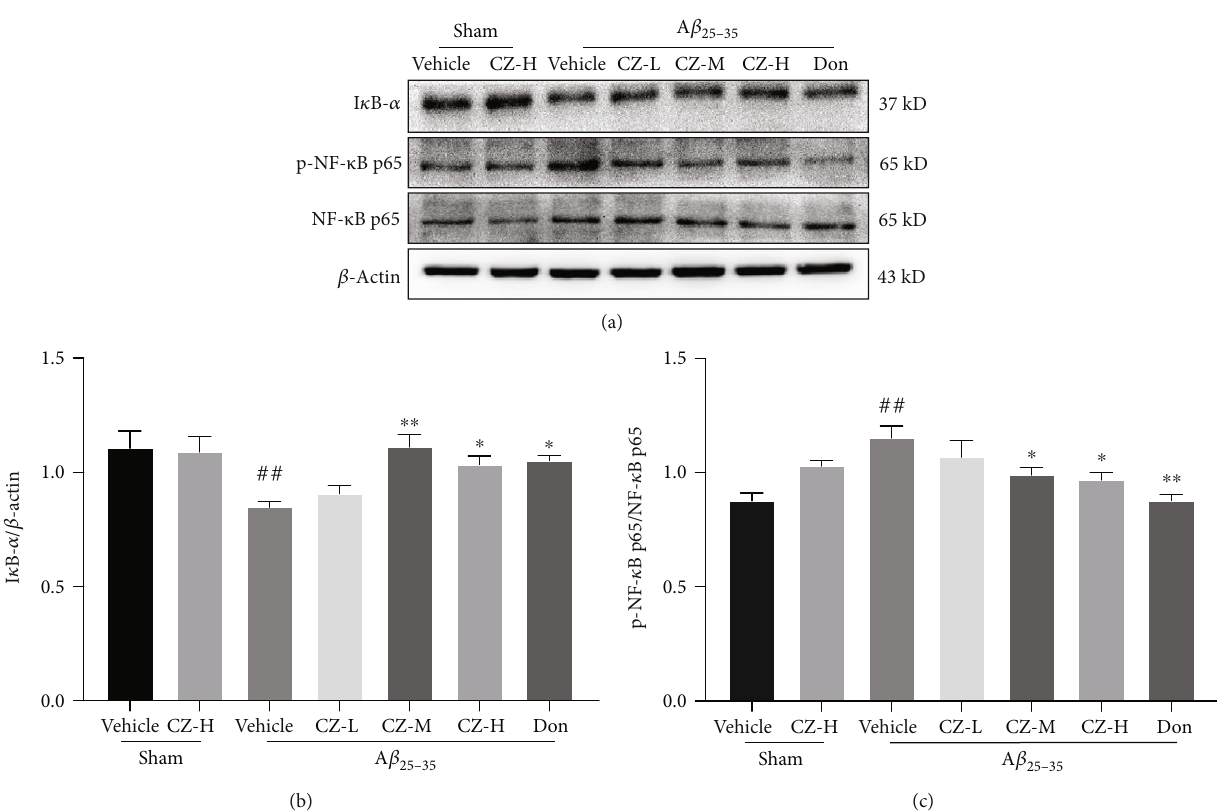
Figure 5: CZYH represses I κ B- α degradation and NF- κ B p65 phosphorylation induced by A β antibody-reactive band of I κ B- α and p-NF- κ B p65 protein expression. (b, c) Statistics of (b) I κ B- α and (c) p-NF- κ B p65 levels. Values are means ± SEM , n = 5 . ## P < 0 : 01 vs. sham; ∗ P < 0 : 05 and ∗∗ P < 0 : 01 vs. A β